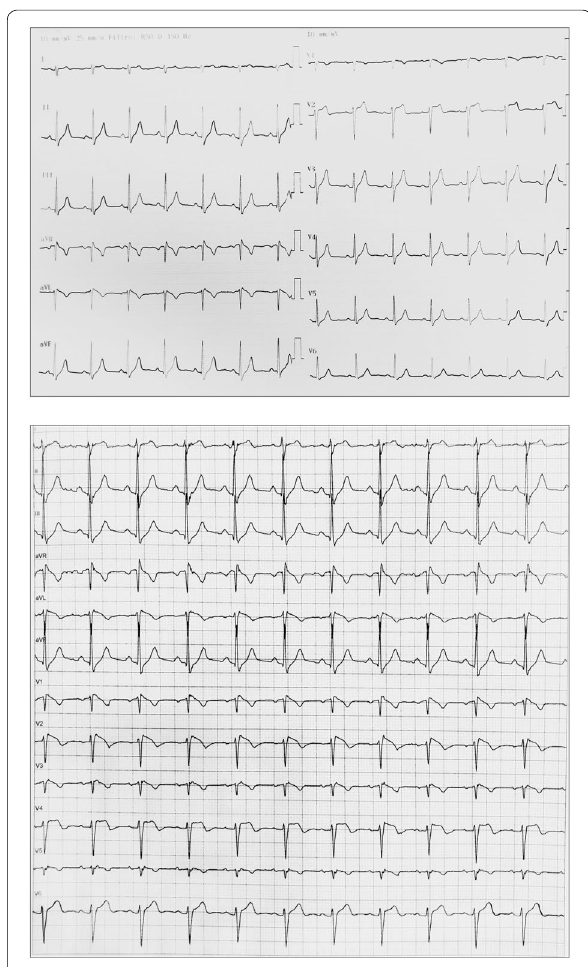
Fig. 2 Original tracings showing an ambulatory ECG done during a therapy suspension period (top panel) and an ECG done during the testosterone therapy (bottom